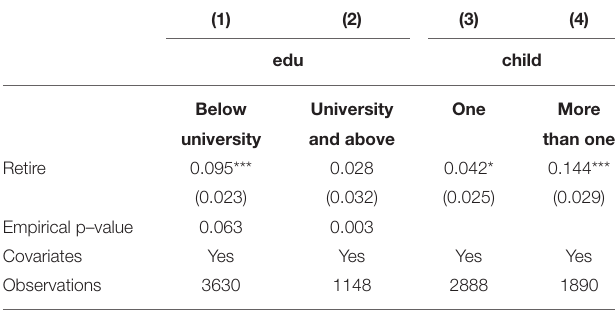
TABLE 8 | The impact of retirement on happiness.